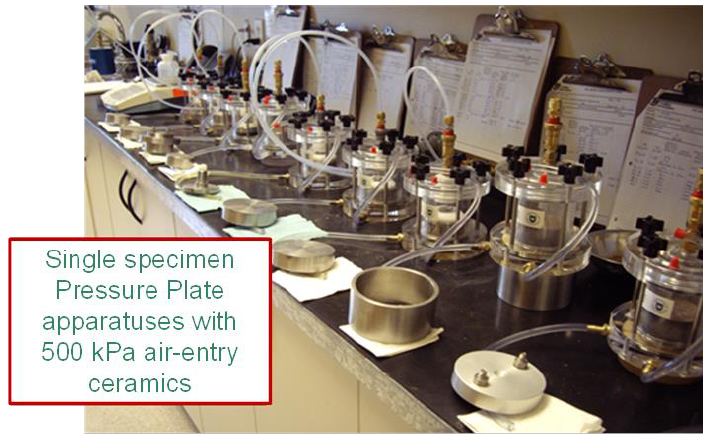
Figure 8. Series of pressure plate cells measuring the water content versus matric suction.